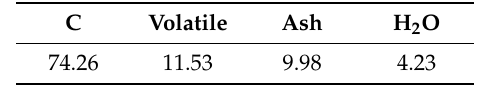
Table 2. Chemical composition of the semi-coke